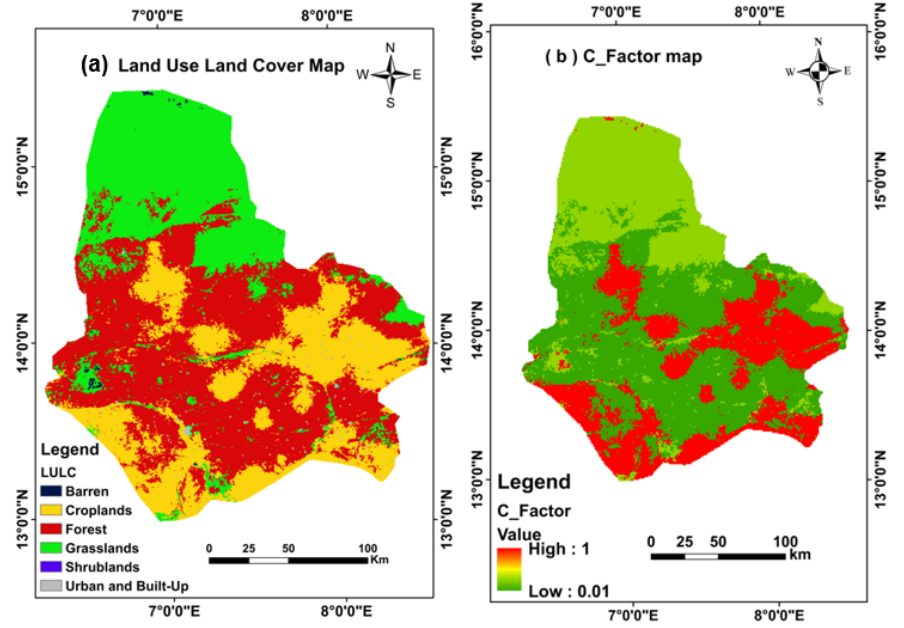
Figure 6. ( a ) Land use/land cover map and ( b ) land cover management (C-factor) map.